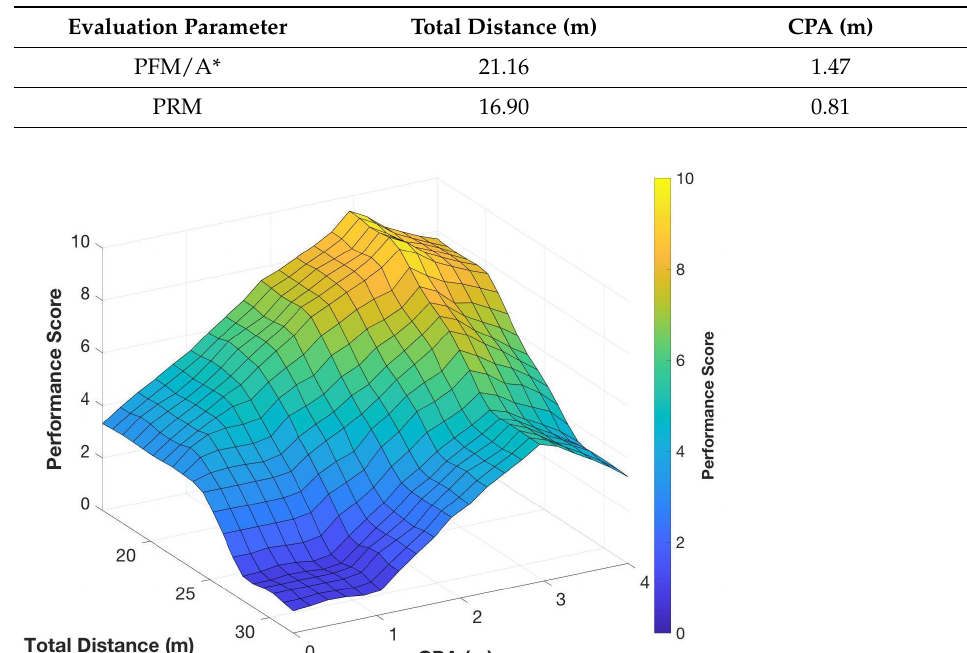
Table 9. Summary of simulated performance values for Case Study II.